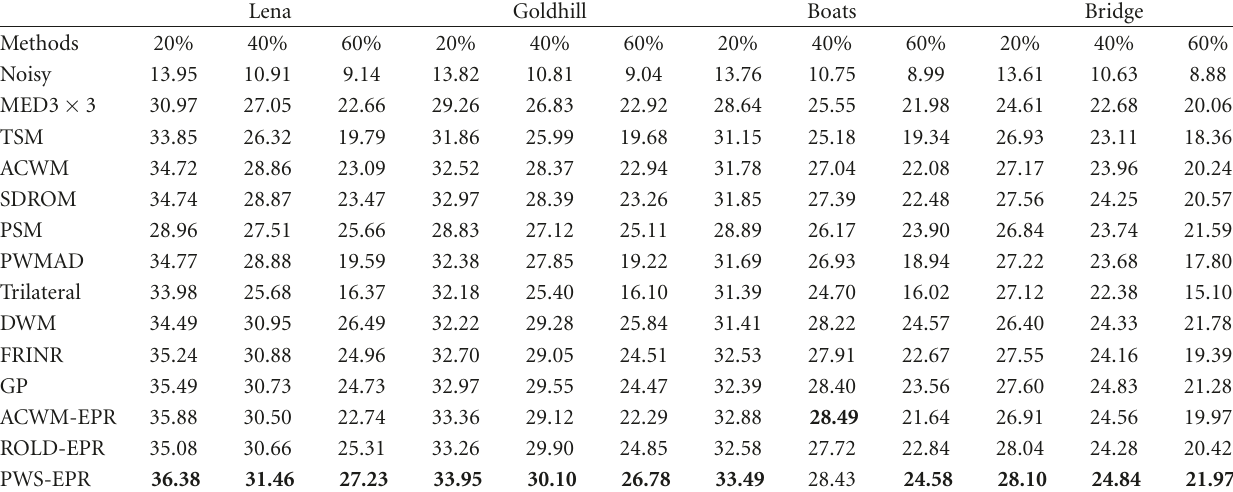
Table 1: Filtering results in PSNR (dB) for images corrupted with mixed impulse noise. Lena Goldhill Boats Bridge